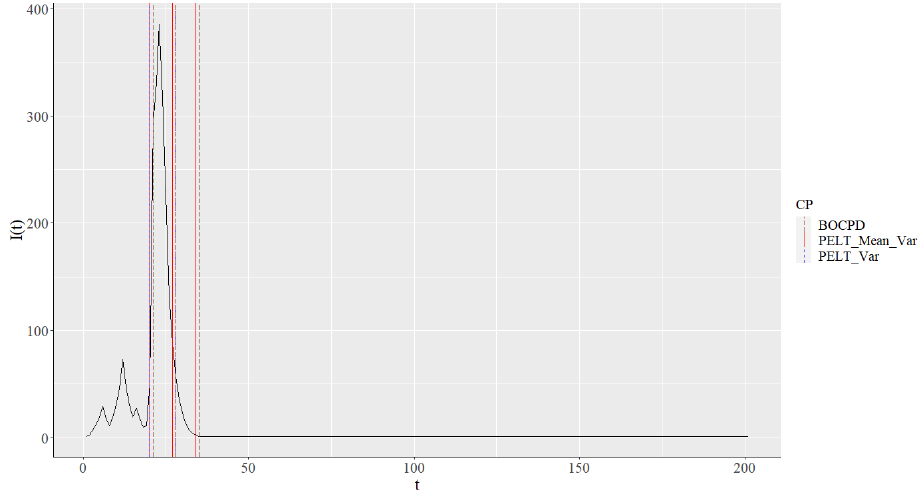
Figure 8. Detection of CPs in the simulated infection compartment ( BOCPD ( m ) = 3, PELT _ Mean _ Var ( m ) = 3, PELT _ Var ( m ) =